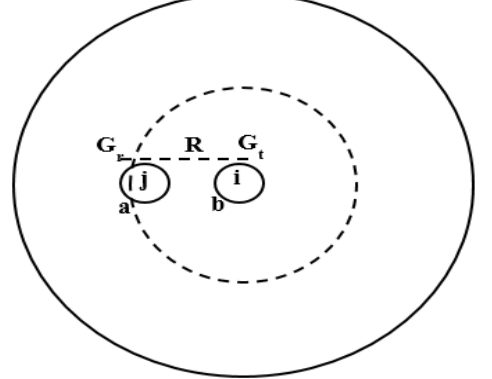
Figure 6. Antenna